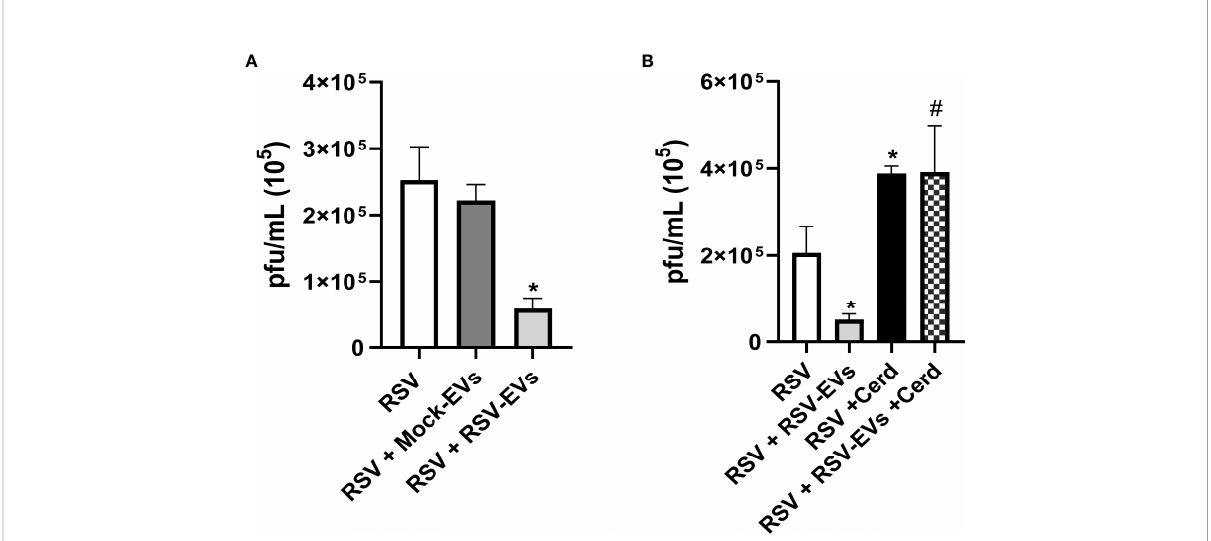
FIGURE 3 Effect of EV treatment on RSV replication. (A) A549 cells were infected with RSV alone (RSV) or treated with Mock-EVs (RSV+Mock-EVs) or RSV- EVs (RSV+RSV-EVs) (15 m g) for 24 hours and then infected with RSV (MOI of 1). (B) A549 cells were infected with RSV alone (RSV), pretreated with RSV-EVs (15 m g) 24 hours prior to RSV infection (RSV+RSV-EVs), infected with RSV and treated with Cerdulatinib (5 m M) 1h prior to infection (RSV-Cerd), or were pretreated with RSV-EVs for 24 hrs, treated with Cerd 1h prior to infection and then infected with RSV at a MOI of 1 (RSV +RSV-EVs+Cerd). Supernatants of infected cells were collected at 24 hours post-infection and viral titers were determined by plaque assay. Data are expressed as mean ± SEM. * indicates a statistical difference compared to RSV alone, while # indicates a difference between RSV-EV treated and RSV-EV treated plus Cerdulatinib groups (* or # for p ≤ 0.05). Data represents the mean average of three independent